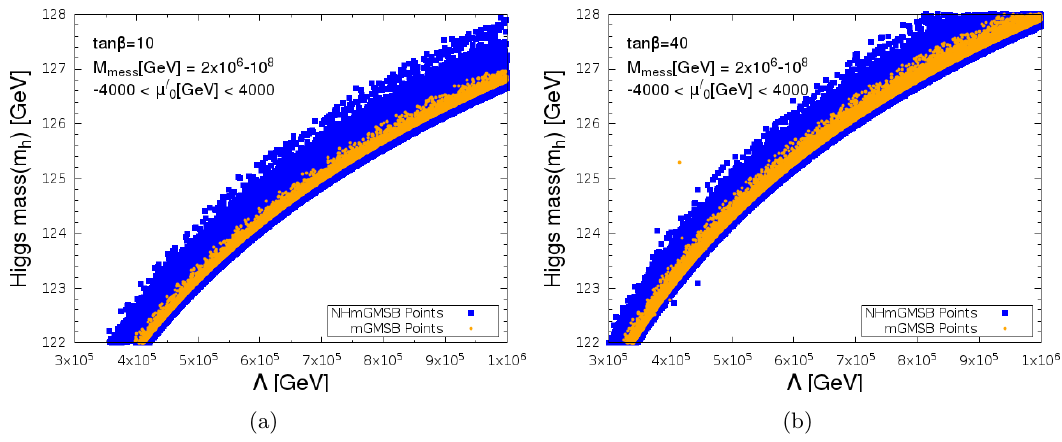
Figure 1 . Scatter plots of m h with (cid:3) are shown for tan (cid:12) = 10 and 40 when M mess and (cid:22) 0 scanned according to the ranges mentioned in eq. (3.2). The blue and yellow coloured regions correspond to NHmGMSB and mGMSB cases